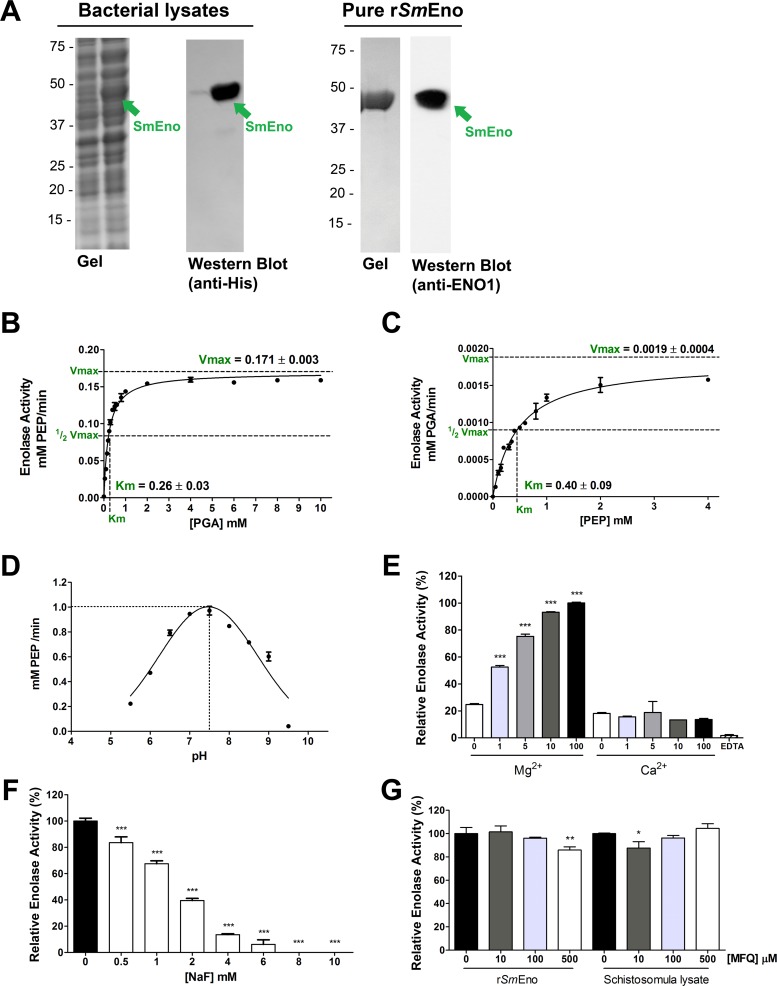
Heterologous expression, purification and kinetics of rSmEno.(A) Heterologous expression of rSmEno in E. coli BL21 Star (DE3). Coomassie-stained gel showing SDS-PAGE resolution of lysates of E. coli bacteria harboring pTrcHisB::SmEno before (Gel, left lane) or 4 hours after (Gel, right lane) protein expression induction. The arrow indicates rSmEno in the induced lane. In western blot analysis of these lysates probed with monoclonal anti-His tag antibody, a prominent ~50 kDa protein (SmEno) is detected (Western Blot, anti-His, arrow). Recombinant SmEno protein was purified from bacterial lysate by immobilized metal affinity chromatography. A single ~50 kDa pure protein (SmEno) is resolved following Coomassie brilliant blue staining of an SDS-PAGE gel and this protein binds anti-ENO antibody, as determined by western blot analysis (right lane, arrow). Positions of migration of molecular mass markers are indicated on the left (kDa). Michaelis-Menten kinetic curve generated using PGA as substrate (B, catalyzing the forward reaction) or using PEP as substrate (C, catalyzing the reverse reaction). The apparent Km and Vmax values shown represent the mean +/- SD of three independent experiments. (D) Recombinant SmEno activity in a buffer system covering the pH range 5.5–9.5. Enzymatic activity is maximal at pH 7.5. (E) Impact of divalent ion (Mg2+ or Ca2+, as indicated) concentration on mean rSmEno activity (± SD). The highest activity value (at 100 mM Mg2+) was set at 100% and relative activities were calculated and are presented. Significant differences relative to equivalent measurements containing Ca2+ are denoted by *** for p <0.001. EDTA is Ethylenediaminetetraacetic acid. (F) rSmEno activity in the presence of increasing concentrations of NaF (white bars) compared to its activity in the absence of inhibitors (set at 100%, black bar). Significant differences relative to the untreated control are denoted by *** for p <0.001. (G) Influence of increasing concentrations of mefloquine (MFQ) on rSmEno activity (left bars) or on schistosomula lysate enolase activity (right bars). Activity measured in the absence of MFQ was set at 100% and relative activities were calculated. Significant differences relative to the untreated control are denoted by * for p<0.05 and ** for p<0.01. In E-F, bars represent mean relative activity ± SD, n = 3.